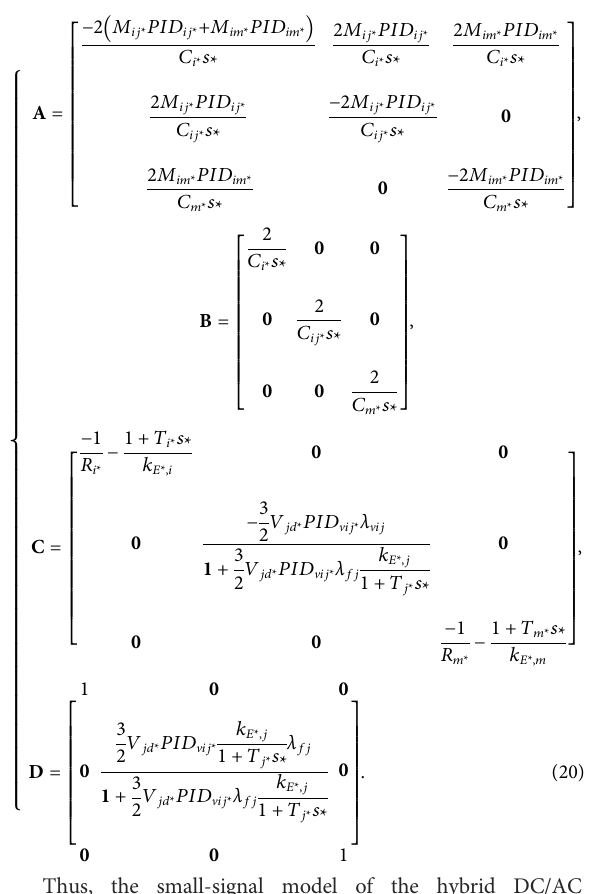
change, the root locus diagram is shown in Figure 6 and Figure 7. In order to maintain simplicity, only a few dominant poles close to the virtual axis are reserved for display.